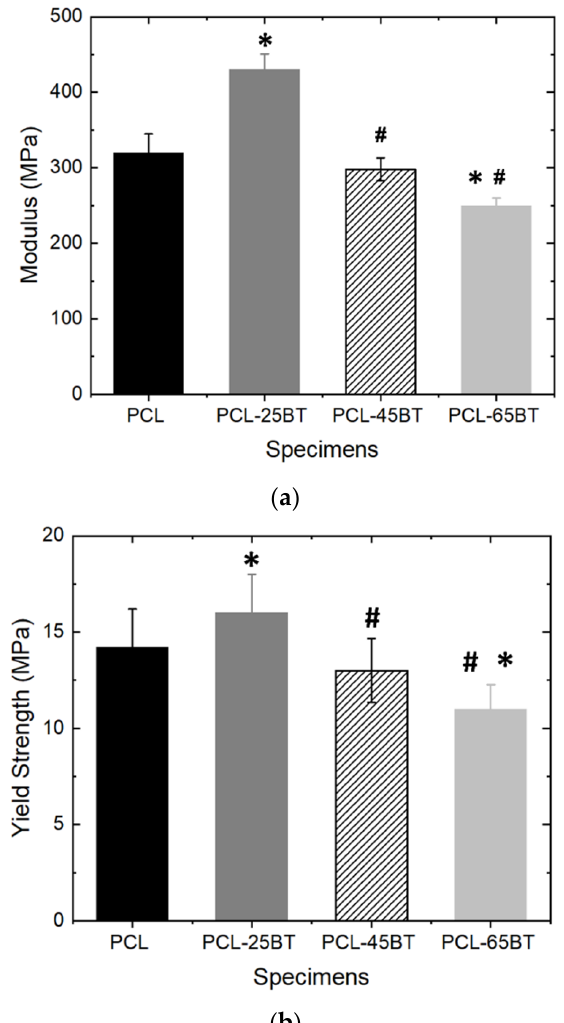
Figure 9. Mechanical testing of the composite specimens. ( a ) Young’s modulus and ( b ) yield tensile strength of the 3D-printed PCL and PCL-BT scaffolds. * means statistically significant ( p < 0.05) with respect to PCL. # means statistically significant ( p < 0.05) with respect to PCL-25BT.